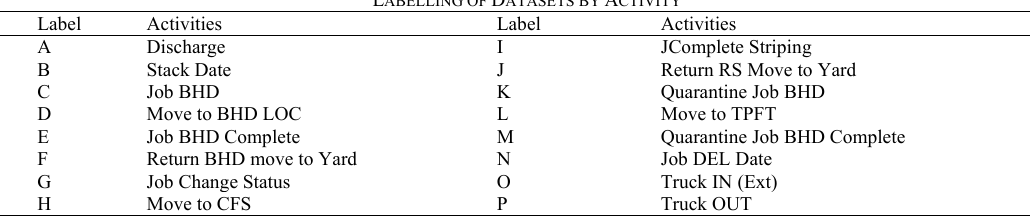
TABLE 1 L ABELLING OF D ATASETS BY A CTIVITY